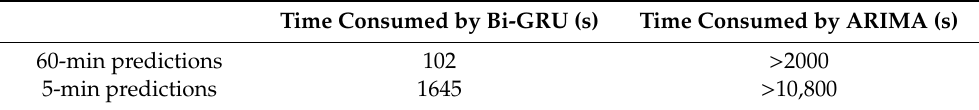
Table 6. Time consumed in training and testing of the single models. Time Consumed by Bi-GRU (s) Time Consumed by ARIMA (s) >2000 1645 >10,800